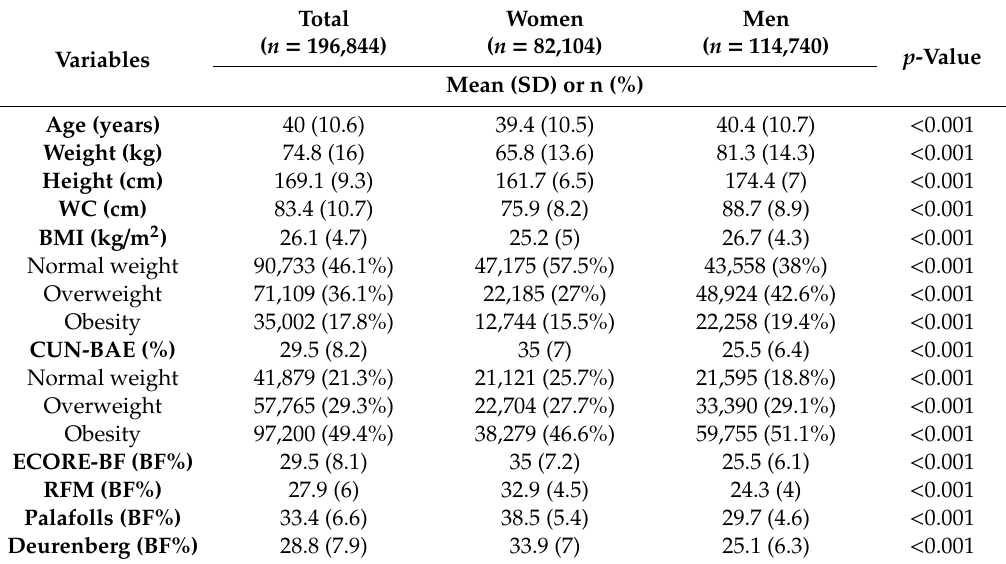
Table 2. Descriptive characteristics of the sample.